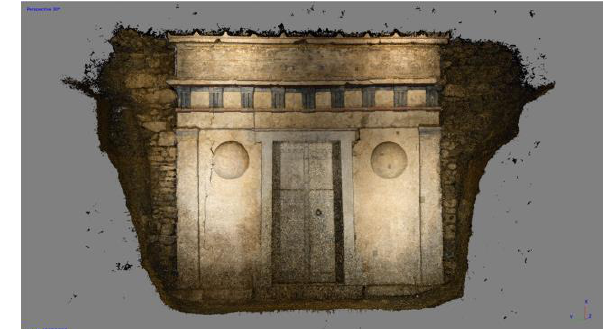
Figure 9. The Tomb of Alexander IV in Verghina. Cloud of dots with noise.